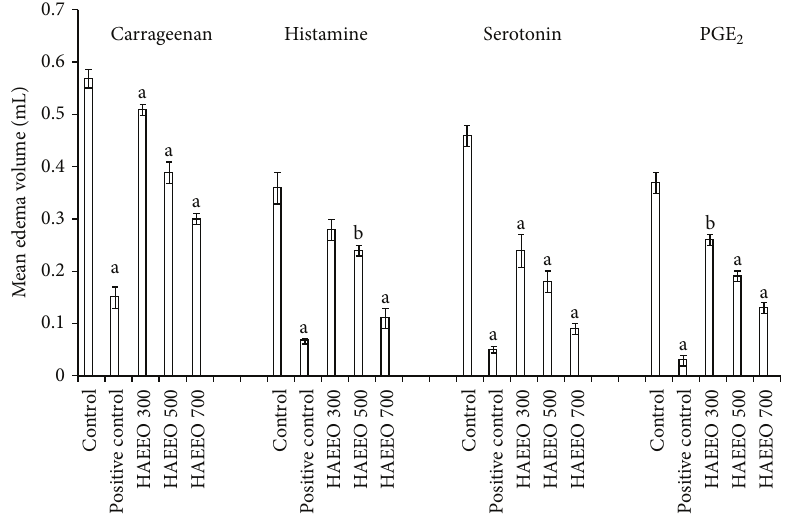
Figure 1: Effect of HAEEO on carrageenan- and autacoids-induced hind paw edema in rats. Each value represents the mean ± S.E.M. ( 𝑛 = 6 ). a 𝑃 < 0.001 and b 𝑃 < 0.01 compared to control. Positive control carrageenan (indomethacin 10 mg/kg), histamine